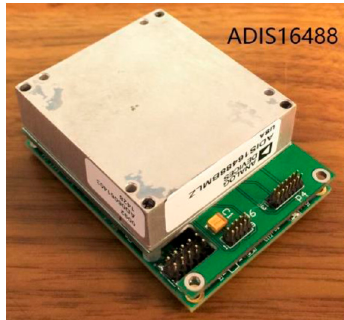
Figure 10. ADIS16488 micro-electro-mechanical-system inertial measurement unit (MEMS-IMU) system.